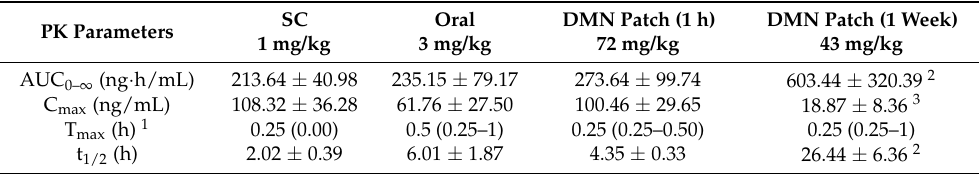
Figure 8. Plasma concentration–time profile of donepezil after 1 week application of DMN patches ( △ ), 1 h application of DMN patches ( ▼ ), and subcutaneous ( ● ) and oral ( ○ ) administration to rats (mean ± standard deviation, n = 5). Timepoints up to 1 h are shown in the insert graph. Table 5. Pharmacokinetic (PK) parameters of donepezil after subcutaneous (SC), oral, and DMN patch application (1 h and 1 week) to rats (mean ± standard deviation, n = 5).